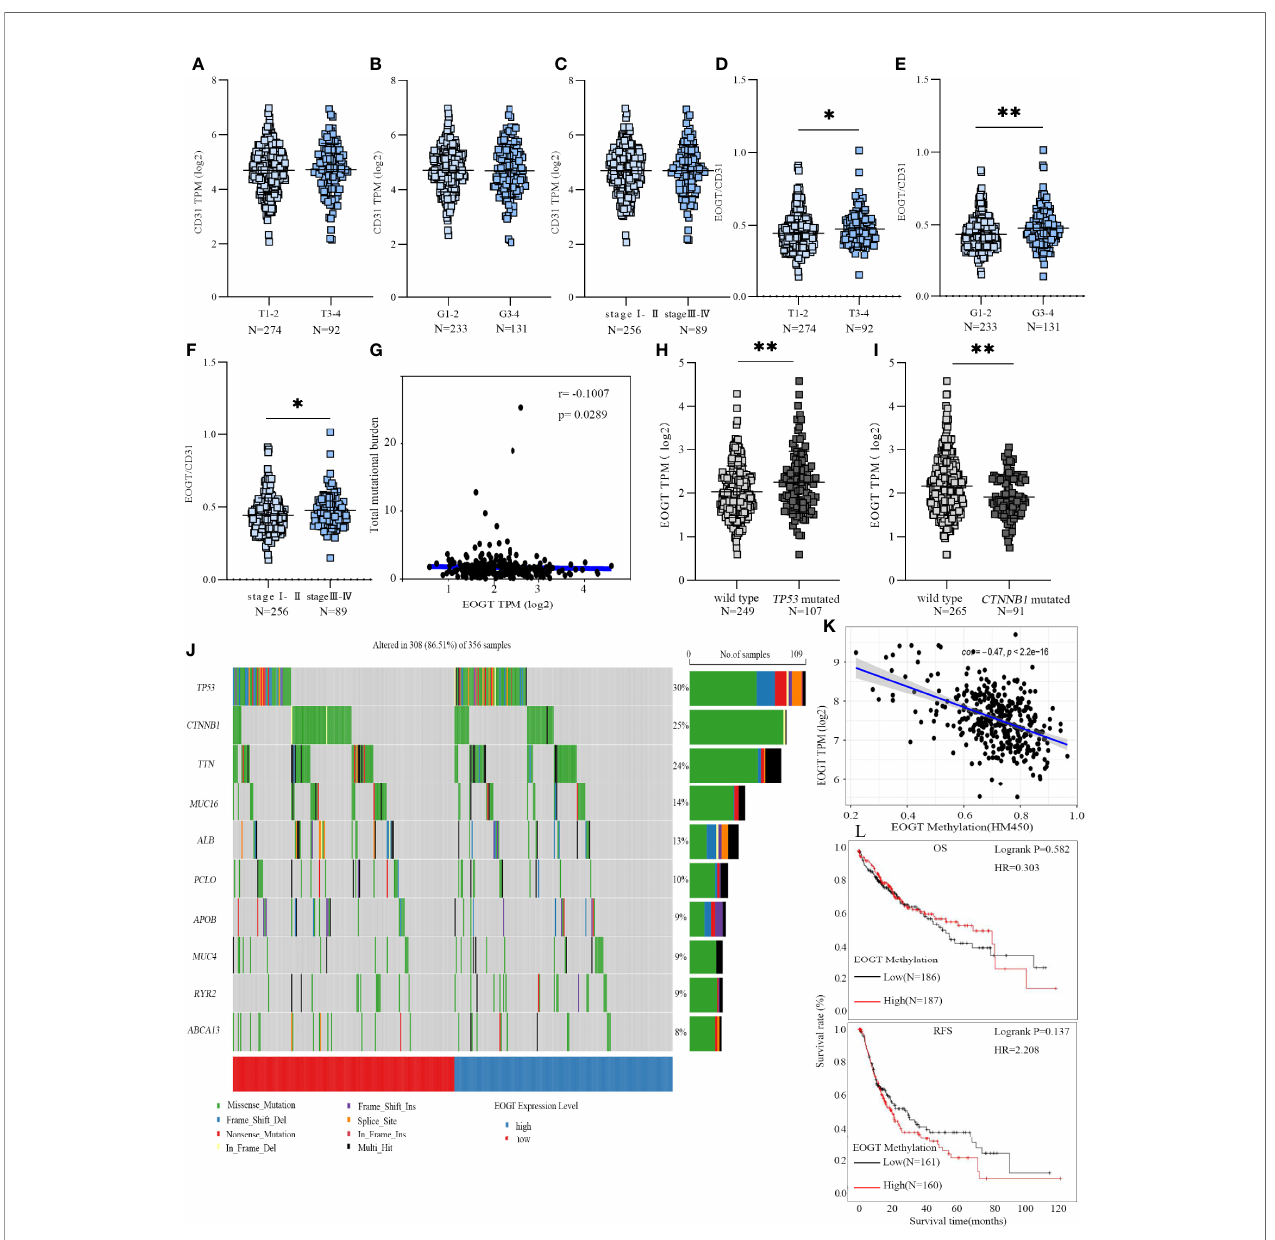
FIGURE 4 | EOGT expression levels were analyzed in HCC patients with different TNM stages (A) , grades (B) , and stages (C) . EOGT/CD31 were analyzed in HCC patients with different TNM stages (D) , grades (E) , and stages (F) . Molecular characteristics of high- and low-EOGT expression subgroups; correlation analysis between EOGT expression and TMB. (G) Differences of EOGT expression between wild-type and TP53 mutated subgroup (H) or CTNNB1 mutated subgroup (I) . (J) Signi fi cantly mutated genes in HCC samples. Mutated genes (rows, top 10) are ordered by mutation rate. The color coding indicates the mutation of each type. (K) Correlation analysis between EOGT expression and EOGT DNA methylation. (L) KM analysis of OS and RFS based on methylation levels of EOGT (* P < 0.05, ** P <